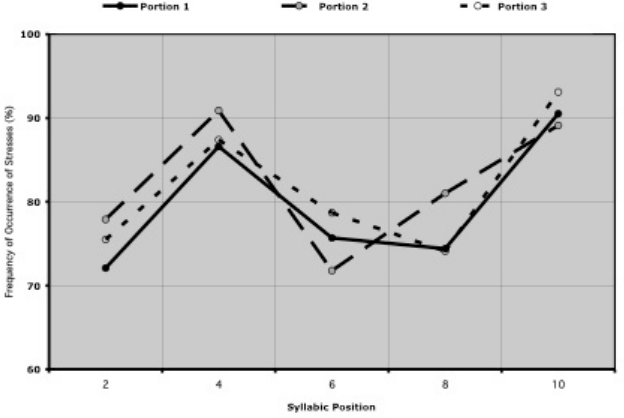
Fig. 3 – Three Portions of Arden of Faversham Stresses on Strong Syllabic Positions As we see, Portion 2 contains a substantial dip on syllable 6 and a peak on syllable 8, while in Portion 1 stressing on 6 and 8 is almost equal, and in Portion 3 the dip decisively falls on syllable 8. The stress profiles of the three portions explain why my earlier results showed equal stressing on positions 6 and 8: the data indicated average numbers. A dip on 6 is typical of early Elizabethan verse; early Marlowe, early Shakespeare and Kyd in his three acknowledged plays all had this stress profile (Tarlinskaja 2014, Appendix B, Table 1). While Shakespeare began to develop a dip on syllable 8 only after 1600, Marlowe had changed already by 1592 in Edward II. Below are typical lines from Arden’s scene 8. The prevalence of such lines creates a stress profile with a dip on syllable